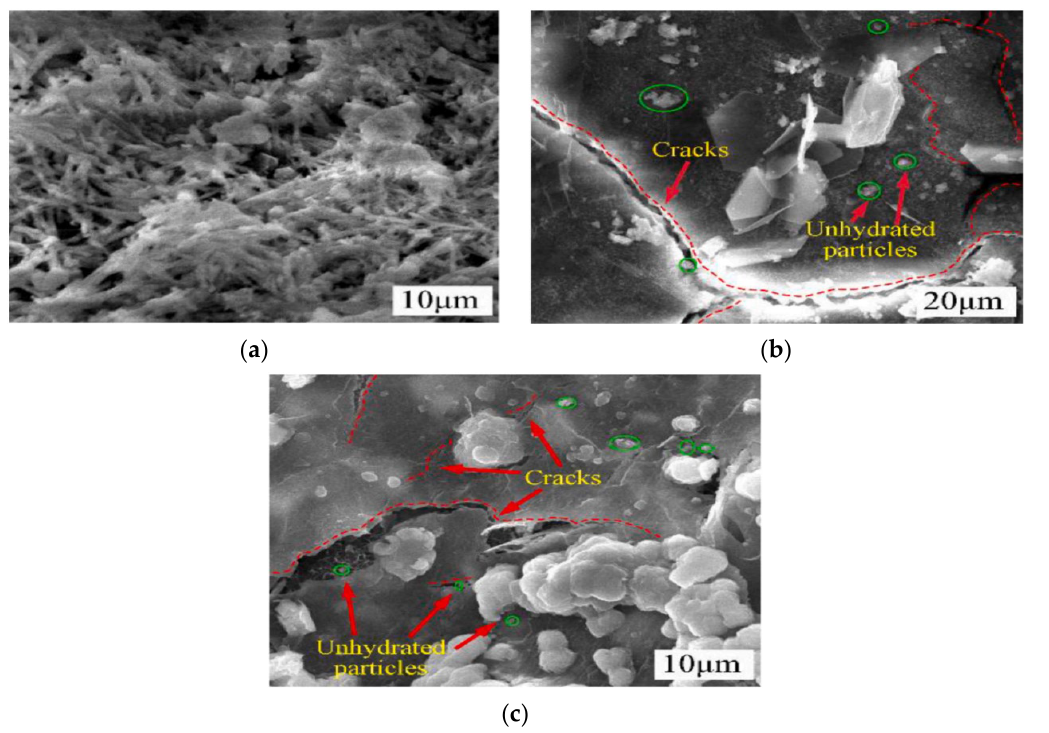
Figure 5. SEM images of mortar consisting of ( a ) OPC ( b ) 30% RCP and ( c ) 50% RCP [170].